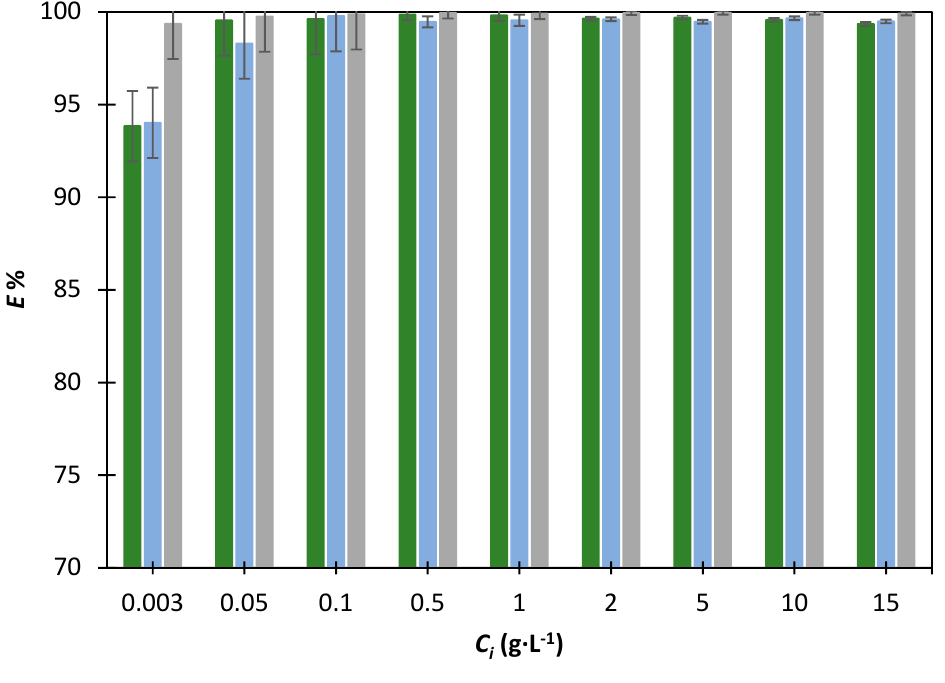
Figure 1. Extraction efficiency ( E %) versus initial concentration ( C i ) of phenol ▬ , o-cresol ▬ and 2-chlorophenol ▬ for the extraction using [EMim][DCA] and 30% of K PO 3 4